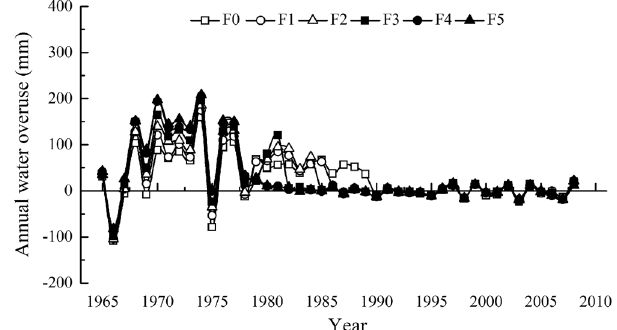
Figure 6. Simulated water over-consumption in the 0–15 m soil layer under different fertilization treatments in the apple orchards of Luochuan.